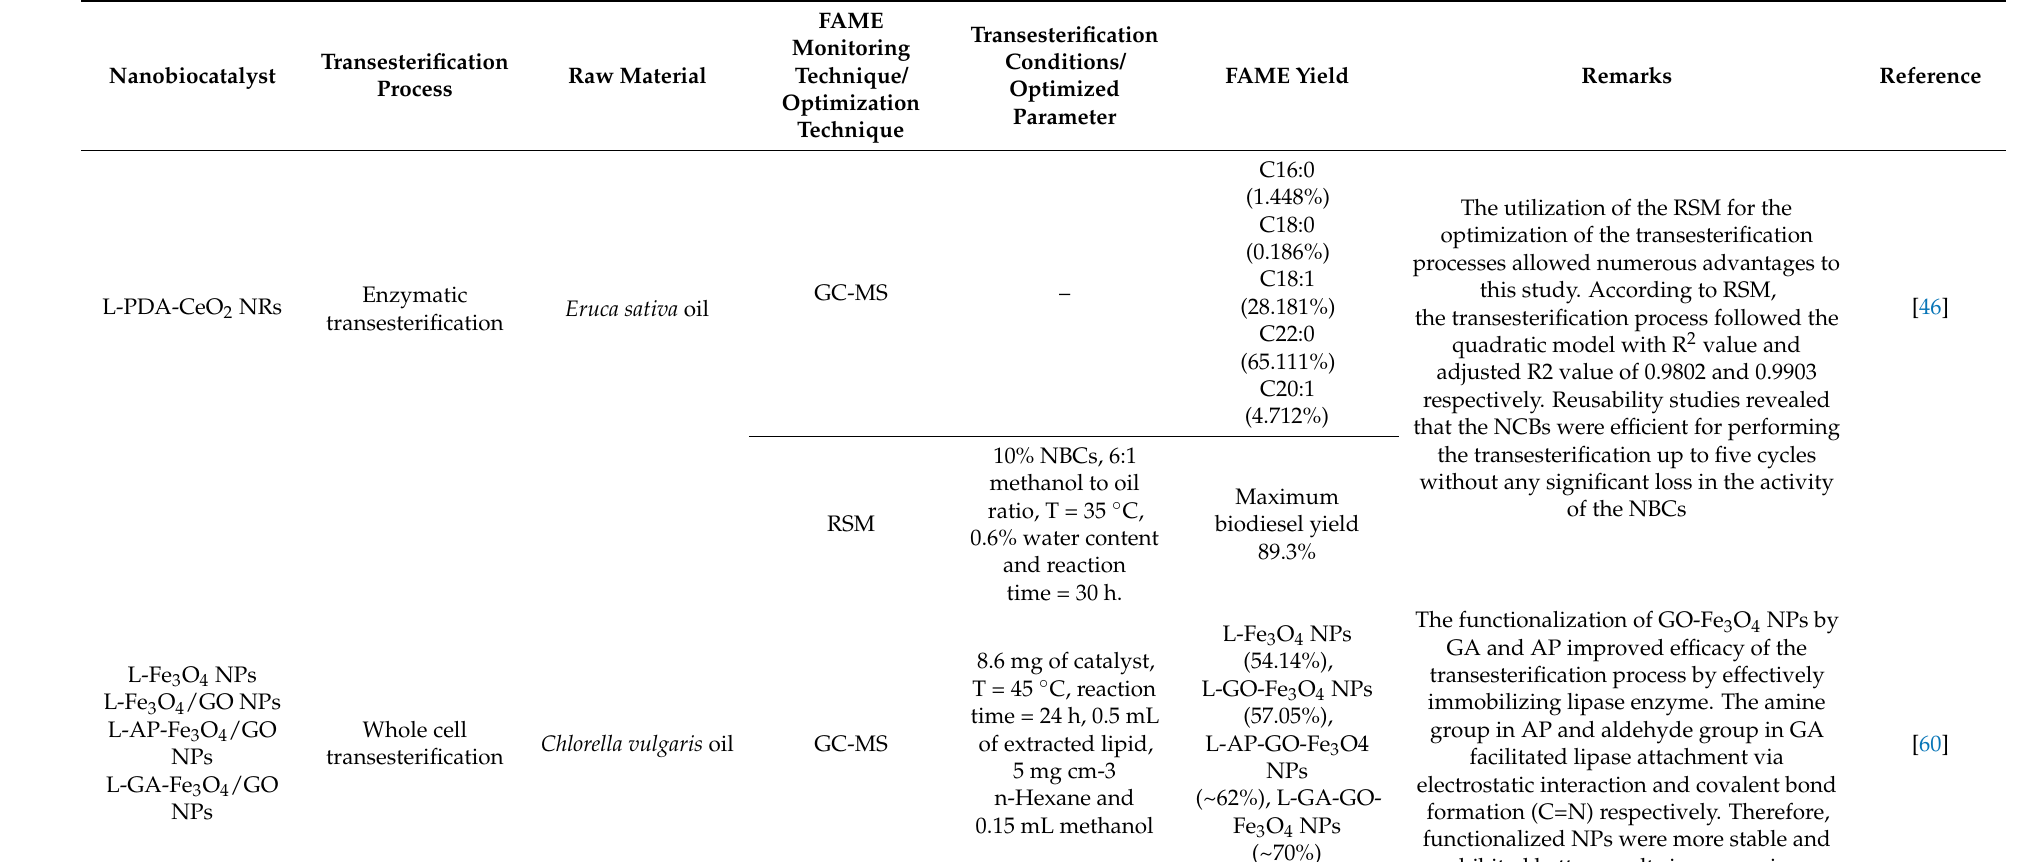
Table 4. Case studies representing the summary of the transesterification process for the production of